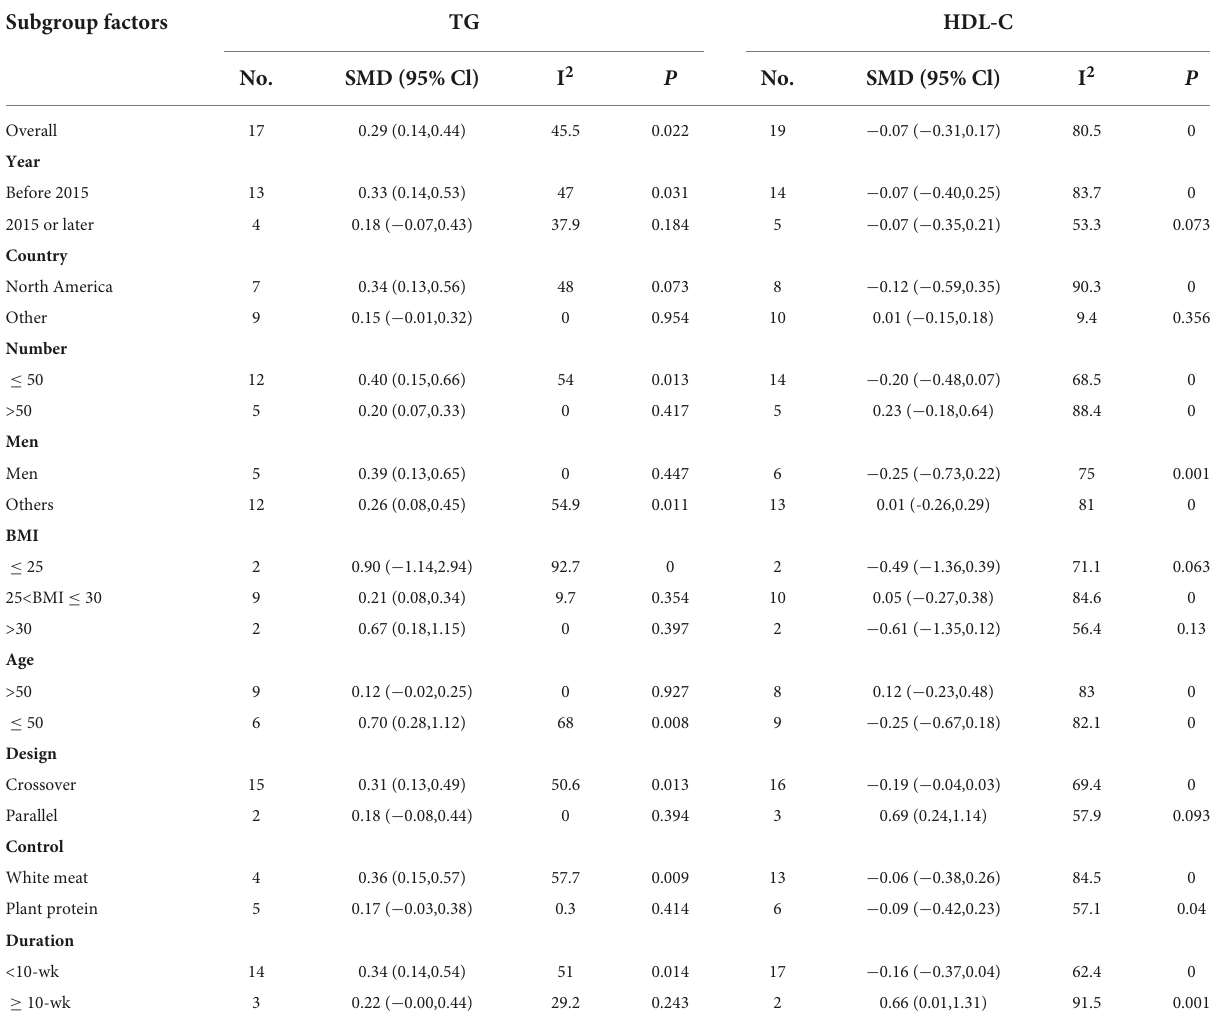
TABLE 7 Subgroup analyses for TG, HDL-C